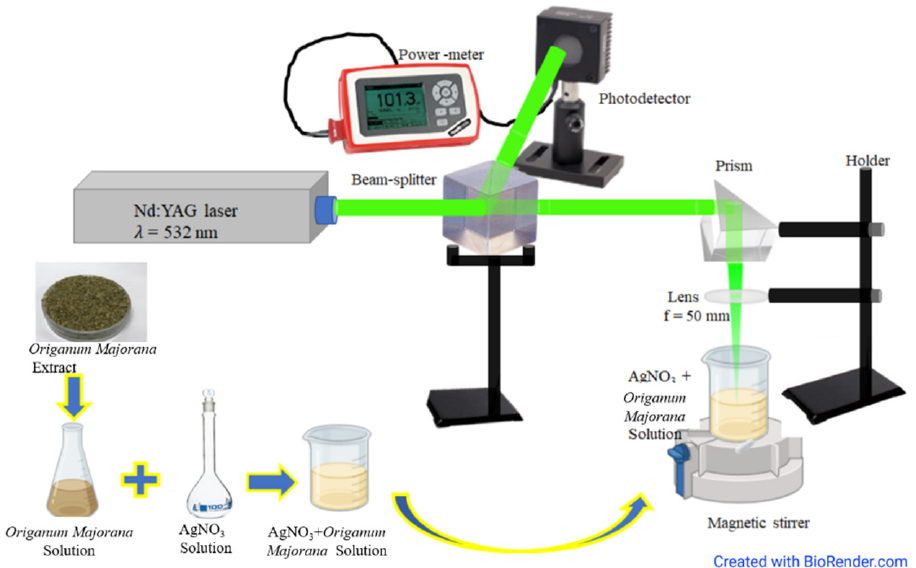
Figure 1. A schematic diagram of the experimental set-up.